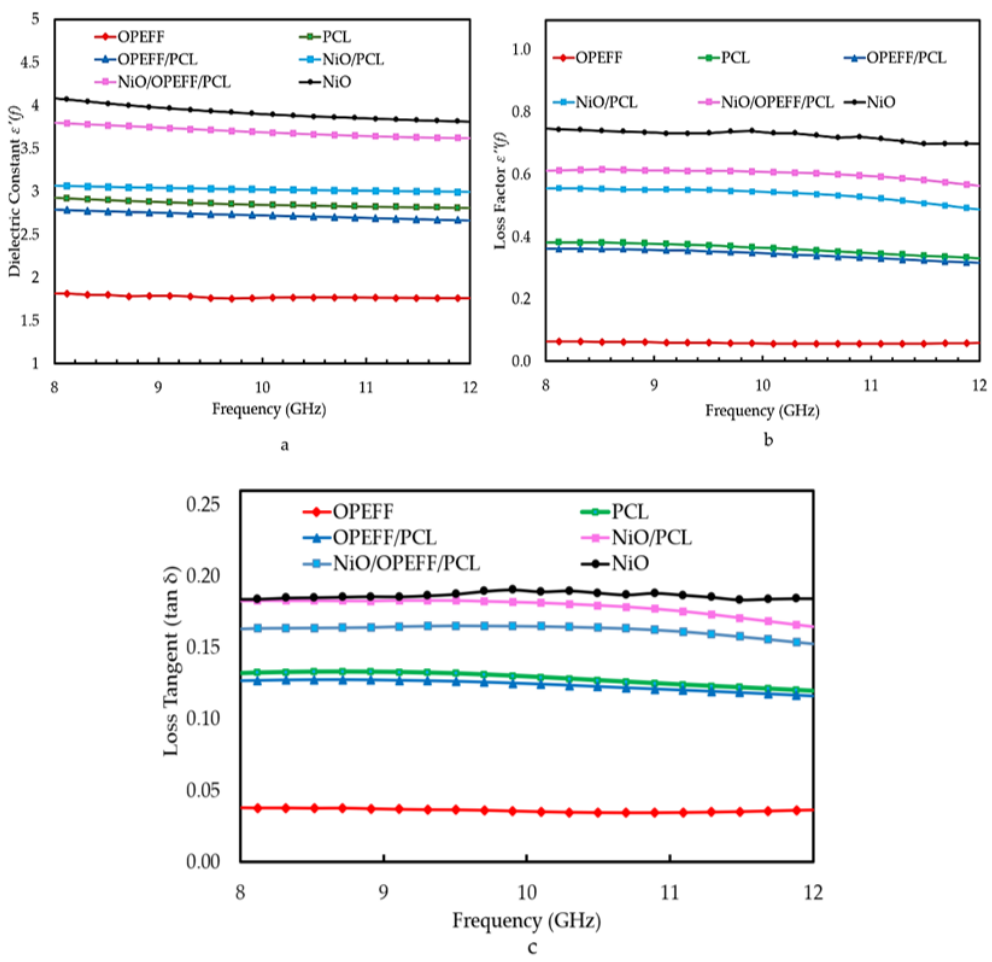
Figure 9. Dielectric properties ( a ) Dielectric constant ( b ) loss factor ( c ) Loss tangent of the substrate material under test OPEFF, NiO, PCL, 12.2%OPEFF/ 87.8%PCL, 12.2%NiO/ 87.8%PCL, and 25%OPEFF/ 25%NiO/ 50%PCL.